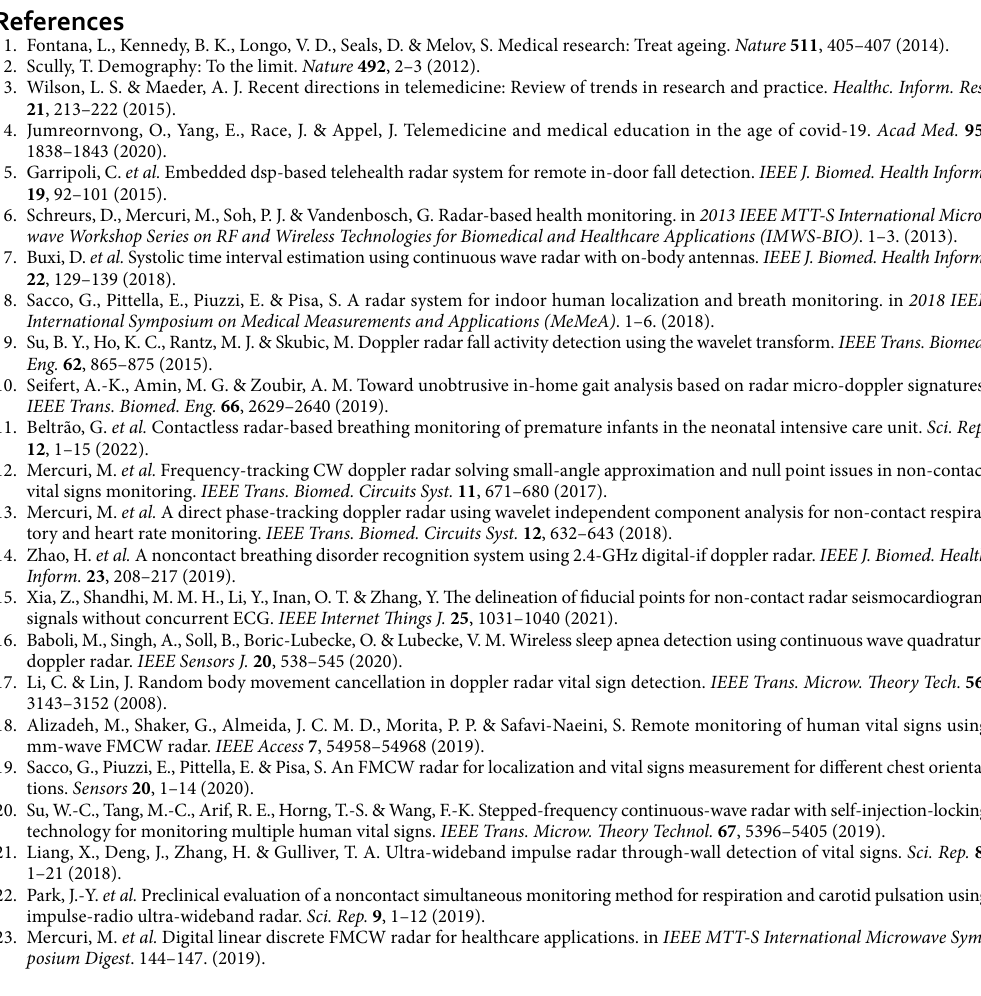
∗ Based on a single